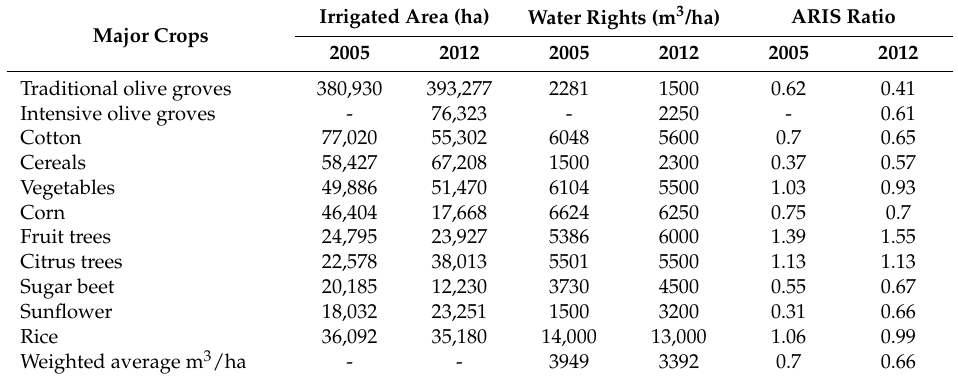
Table 3. Irrigation rights and annual relative irrigation supply (ARIS) ratios for major crops in the Guadalquivir basin